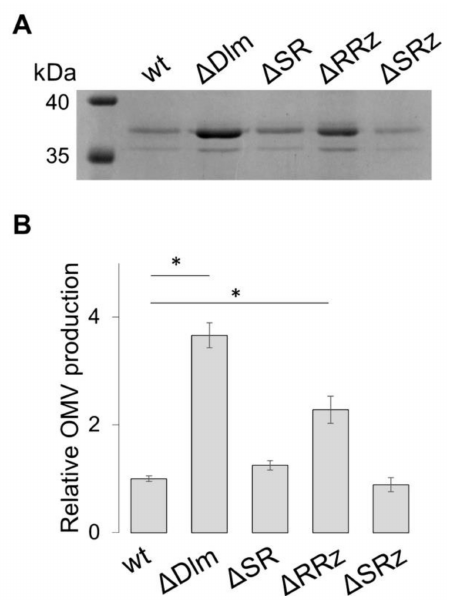
Figure 5. OMV production in ULS153 derivative strains lacking two genes of the DLP12 lysis module. ( A ) SDS-PAGE separation of OMV proteins from ULS153 (wt) and its derivatives lacking the entire DLP12 lytic module ( ∆ Dlm), essD and ybcS ( ∆ SR), ybcS and rzpD / rzoD ( ∆ RRz) or essD and rzpD / rzoD ( ∆ SRz). ( B ) OMV production by ULS153 ∆ Dlm, ∆ SR, ∆ RRz and ∆ SRz normalized to the wt. OMV quantification was obtained by densitometry of the OmpF/C band in SDS-PAGE separations. Vertical bars indicate the standard deviation of three independent experiments. Statistical significance was determined by the t test, and p values are as follows: * p <